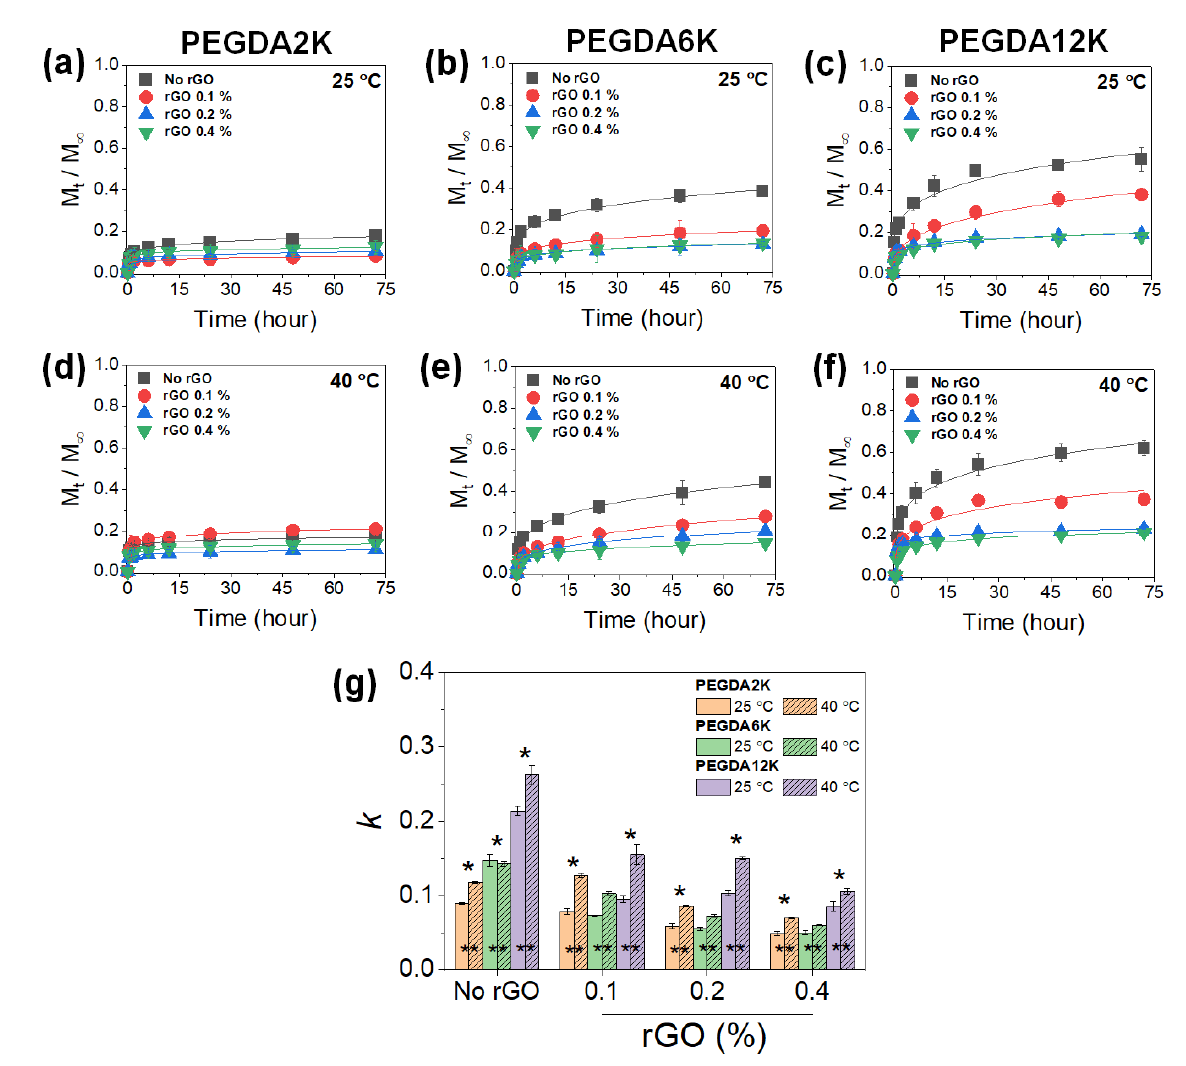
Figure 5. Cumulative release ( M t / M ∞ ) profiles of BSA released from PEG-PNIPAm hydrogels with varying M W of PEGDA and rGO concentration measured at 25 °C or 40 °C. ( a , d ) PEGDA2K, ( b , e ) PEGDA6K, and ( c , f ) PEGDA12K. The concentration of PEGDA was 10%. ( g ) Release kinetic